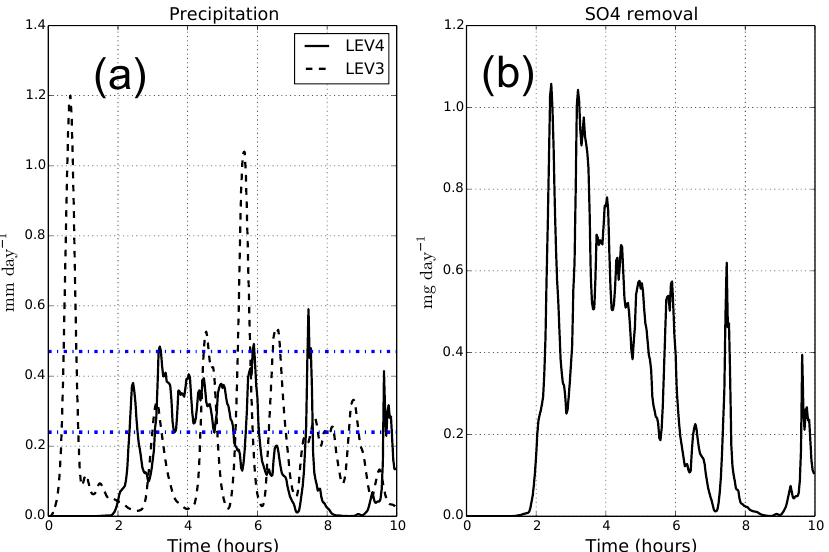
Figure 4. (a) Surface precipitation rate in mmday − 1 and (b) removal rate of sulfate embedded in precipitating drops in mgday − 1 . Results from LEV3 are shown with a dashed line while those from LEV4 are shown with a solid line. The blue horizontal lines in panel (a) indicate range of observed values as shown in Ackerman et al. (2009).